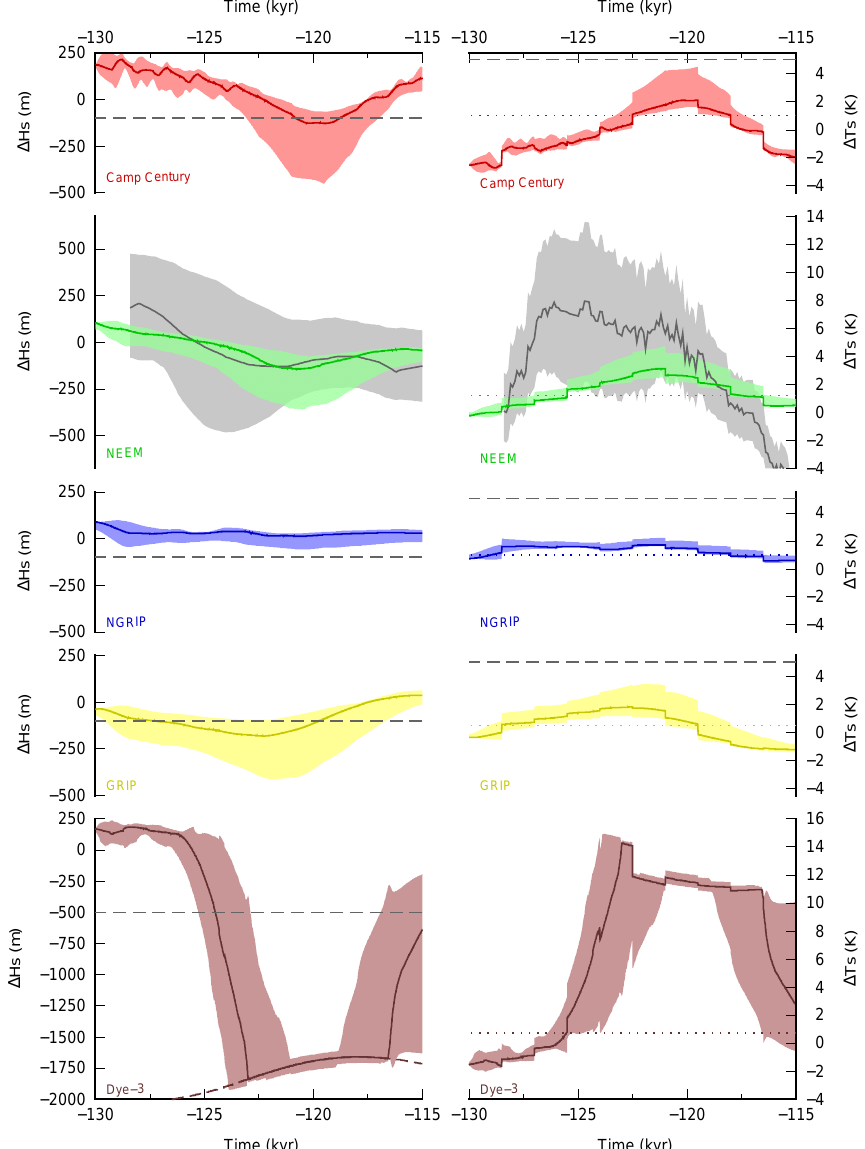
Fig. 8. Surface elevation and temperature at deep drilling sites. Time series of surface height change (left panels) and mean annual surface temperature (right panels) at five deep drilling locations, relative to present day. Coloured lines and shading represents results from our reference run with uncertainty. Estimates of minimum elevation and maximum air temperature as reconstructed from ice cores (NGRIP members, 2004) are shown as dashed grey lines; solid grey lines and shading represent results from the NEEM ice core record with its uncertainty (NEEM community members, 2013), and the lower (brown) dashed line in bottom panel denotes bedrock. Note that due to their close proximity, we do not make a distinction between GRIP and GISP2 in our